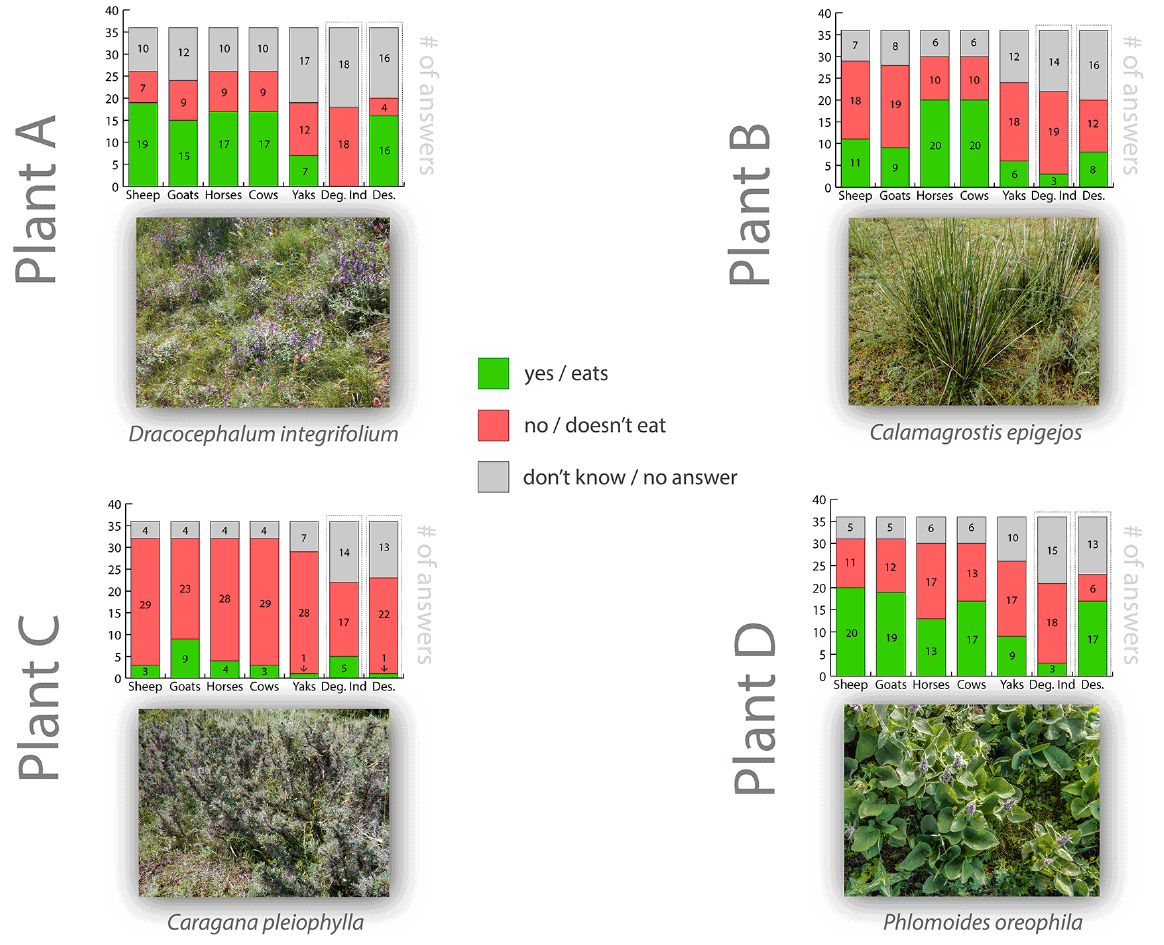
Fig. 4 . Interparticipant agreement on edibility, degradation indicator status, and desirability of plants, grouped by